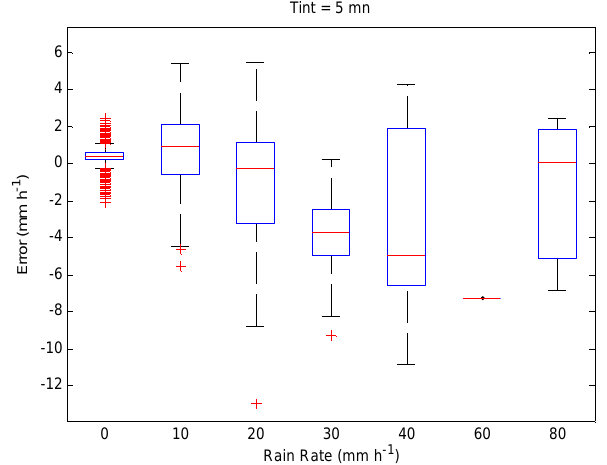
Fig. 2. Error induced on the rain estimation when the ITU power law is used for an integration time equal to 5 min. For each rain bin, the box-and-whiskers diagram indicates the median (central vertical line), and the lower and upper quartiles (left and right edges of the box). The whiskers indicate the lower and upper limits of the distribution, within 1.5 times the interquartile range, from the lower and upper quartiles, respectively.